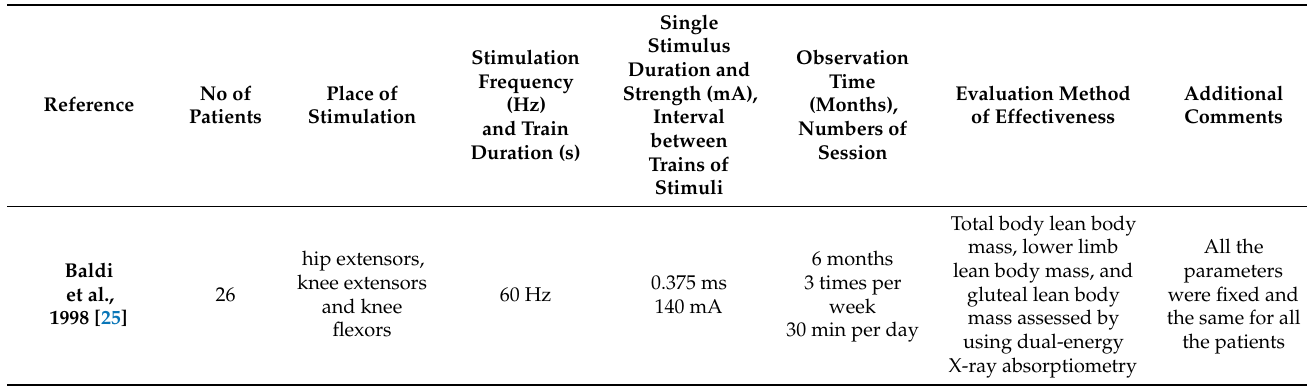
Table 5. Data on parameters of peripheral electrostimulation in patients with spinal cord injury gathered from the available literature and from observations where effects confirmed its